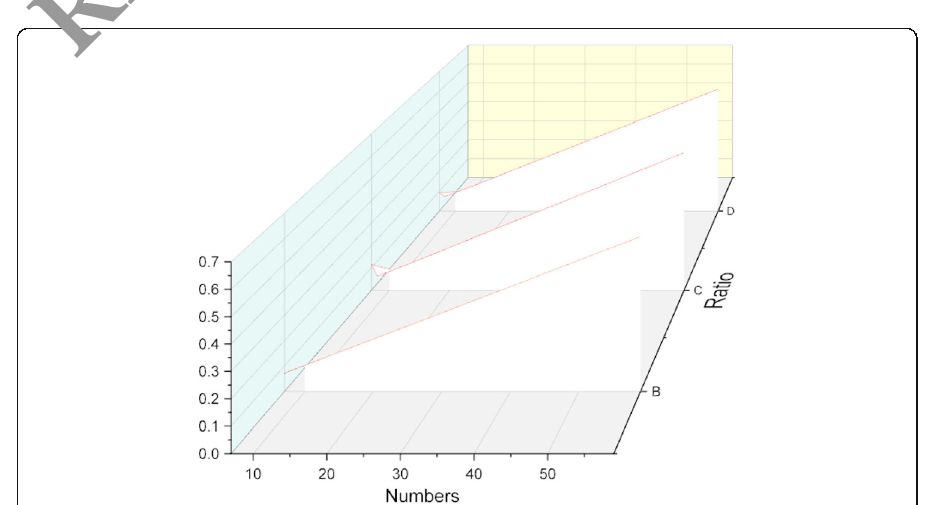
Fig. 2 Difficulties in learning